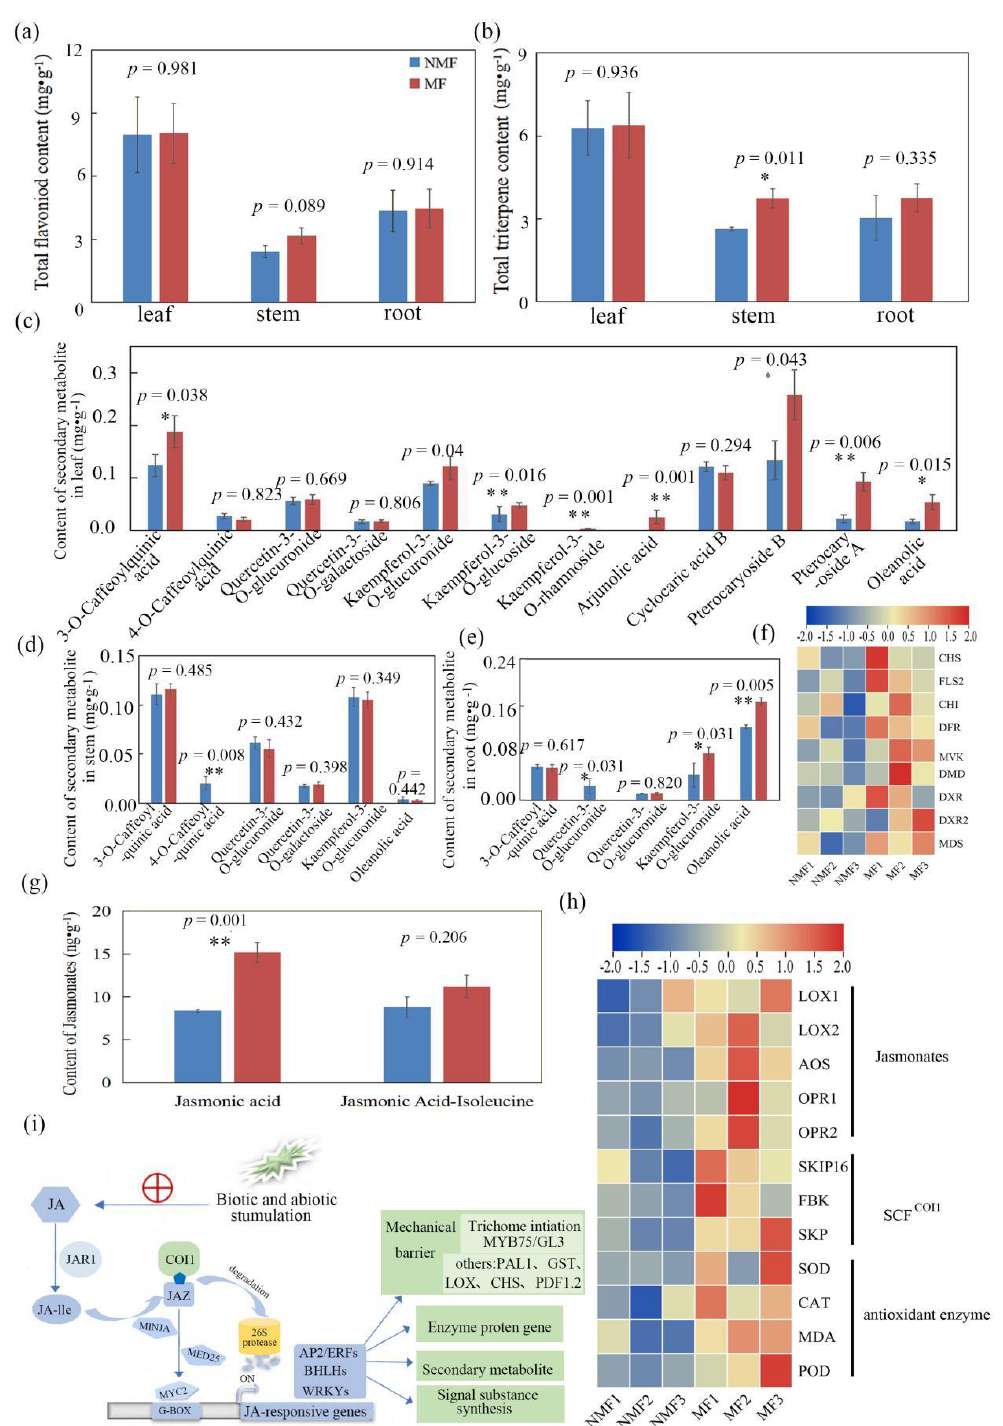
Figure 4. Influence of mycorrhizal fungal colonization on accumulation of secondary metabolites in different organs of C. paliurus . ( a , b ) the content of total flavonoid and total triterpene in different organs; ( c − e ) the content of individual secondary metabolites in leaves, stems and roots, respec-